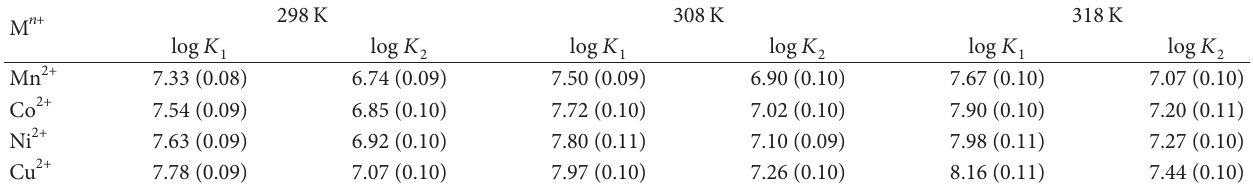
T 4: Stepwise stability constants for ML and ML